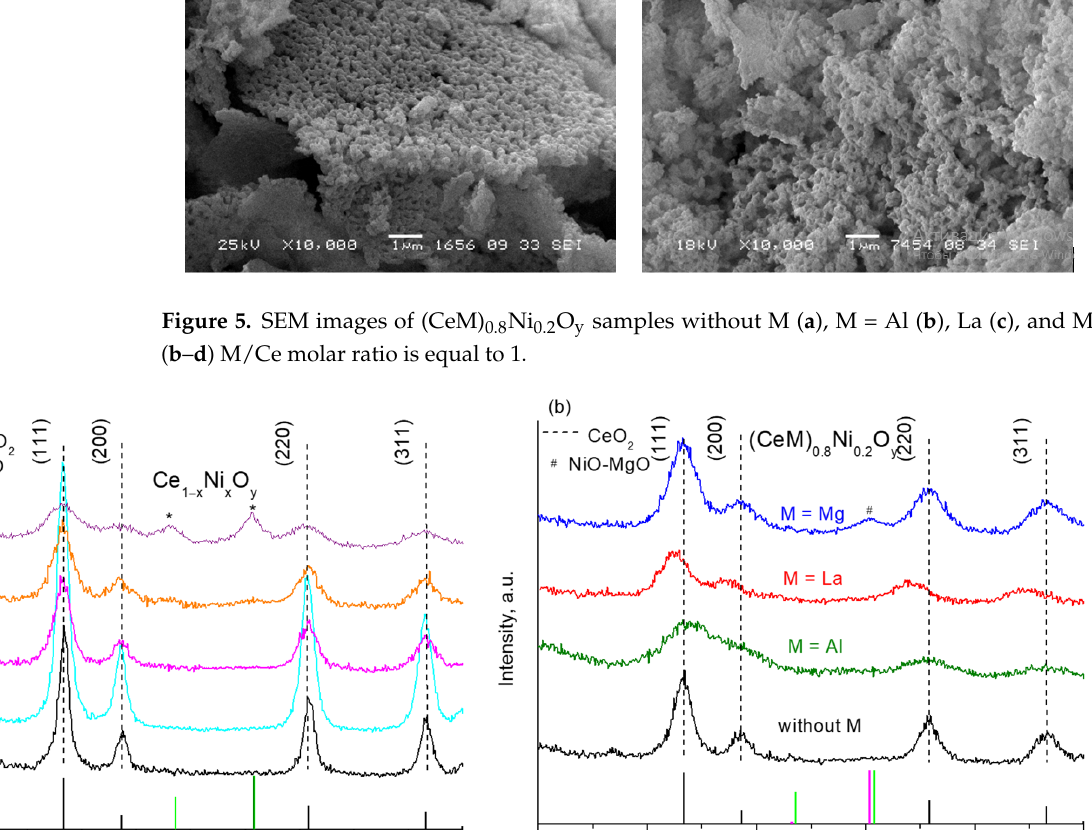
Figure 6. XRD patterns for (CeM) 1 − x Ni x O y (M = Al, La, Mg) samples: effect of Ni molar fraction ( a ) and M type ( b ). ( b )—M/Ce molar ratio is equal to 1. The standard patterns of CeO 2 (ICDD 43–1002, black bars), NiO (ICDD 44–1159, green bars), and MgO (ICDD 45–0946, magenta bars) are shown.